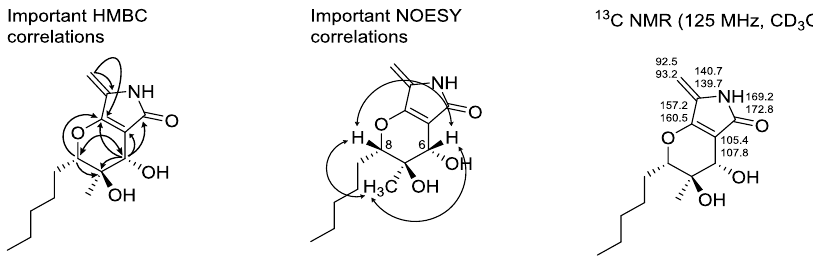
Figure 3. Structural characterization of synthetic compound 17 (* Upper values: PPPC ( 3 ) [1], Lower values: Synthetic 17; Reproduced with permission from [1]).